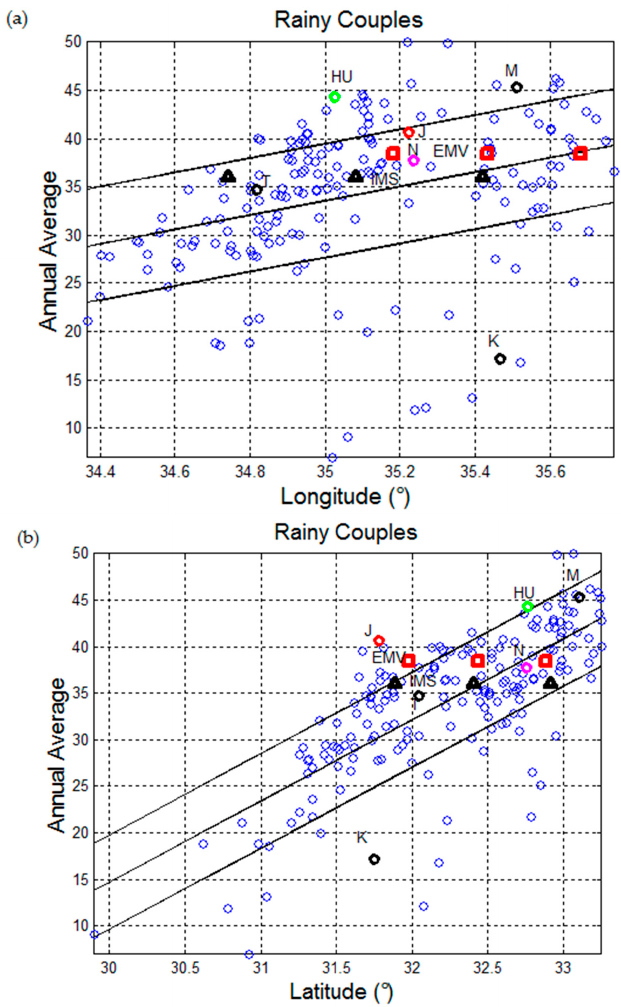
Figure 4. Annual average value of rainy couples of 184 localities of the Holy Land versus longitude (a) and latitude (b) from 1990 to 2015, according to the IMS. Triangles refer to the average value versus the average longitude or latitude and ± 1 standard deviation of these parameters. Squares refer to the value obtained from the EMV (38.4) for the average longitude or latitude and ± 1 standard deviation of these parameters for the 159 localities with latitude > 31.5° (minimum latitude of the localities of Table 3). Explicitly indicated are the values of Jerusalem (J), Tel Aviv (T), Haifa University (HU), Nazareth (N), Malkiya (M), Kalya (K).